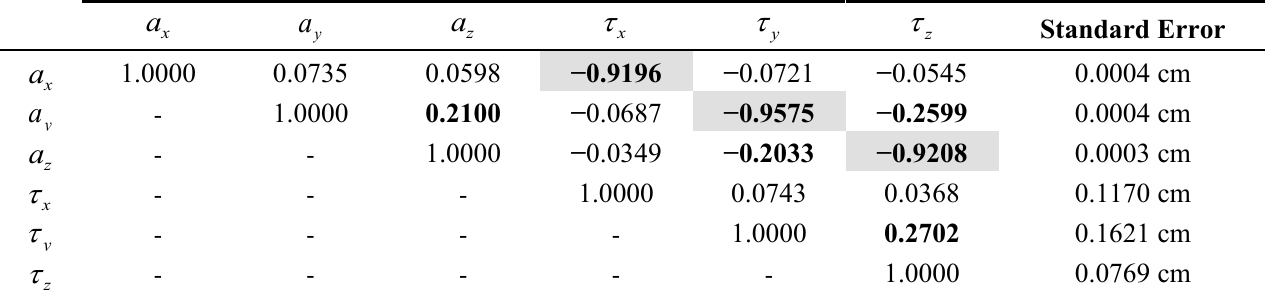
Table 3. Average correlation matrix and estimated error of linear parameters.